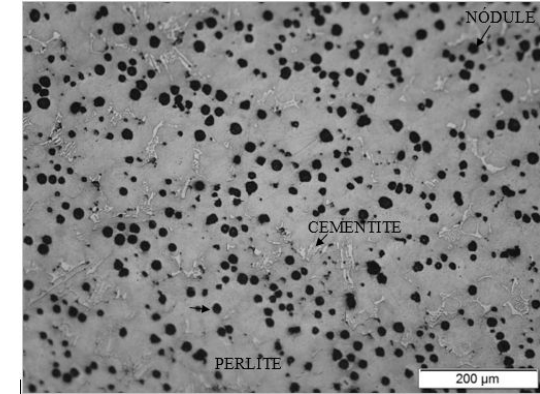
Figure 11. Matrix for Ni addition.